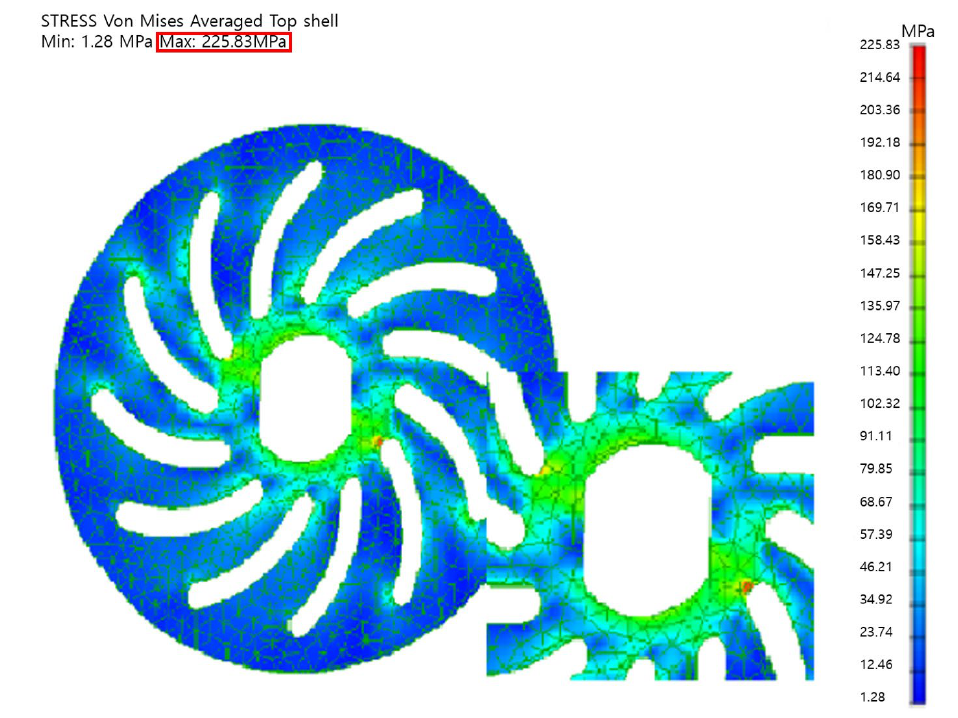
Figure 13. Analysis of plate.